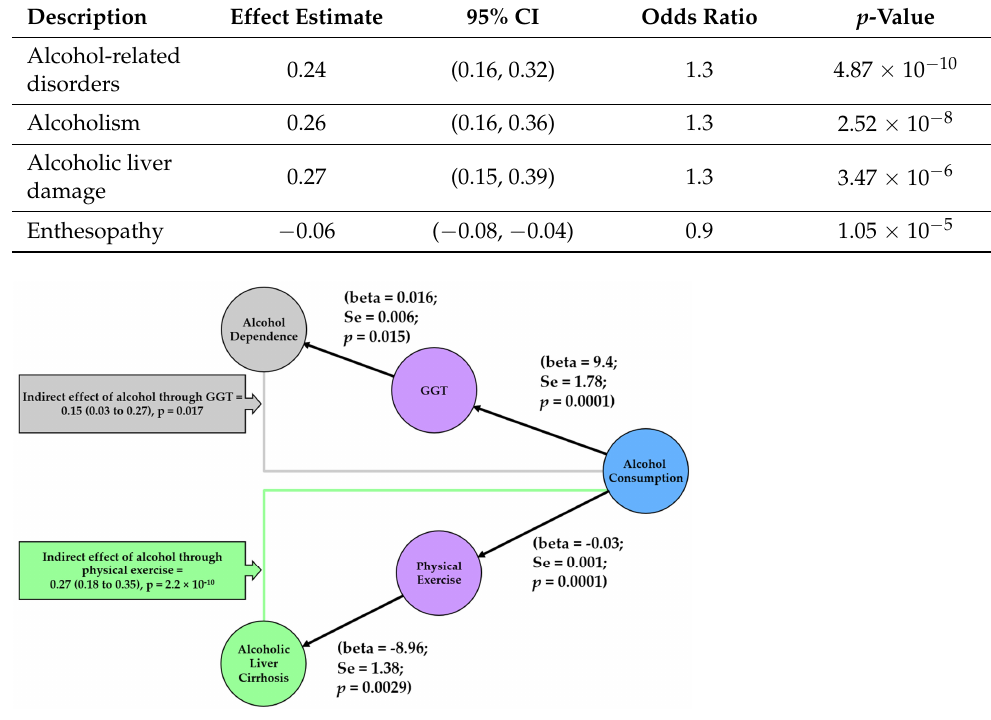
Figure 5. Network to summarise mediators of alcohol consumption and alcohol related diseases. Each node represents a phenotype that was included in mediation analysis. The color of the nodes indicates the source from which the test statistics for genetic associations were obtained. Blue refers to the GWAS by Liu and colleagues [15], purple refers to the UK biobank GWAS by Neale lab, green refers to the GWAS by Buch and colleagues [18], and grey refers to the GWAS by Olfson and colleagues [17]. Results from the MR analysis between each pair of phenotypes is depicted on the edges. For indirect effect, beta from the Sobel method is given together with the 95% CI in brackets and the p value for the Sobel method’s z value. beta, effect estimate from Mendelian Randomisation; Se, standard error; p , p -value; GGT, Gamma Glutamyl